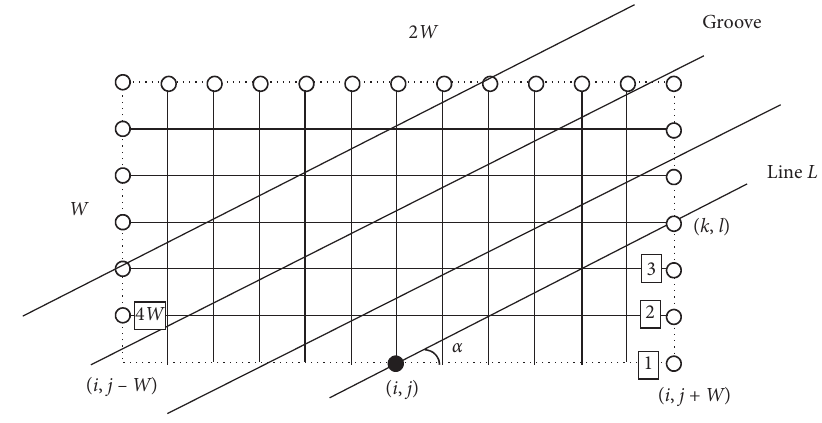
Figure 2: W × 2 W neighborhood and its